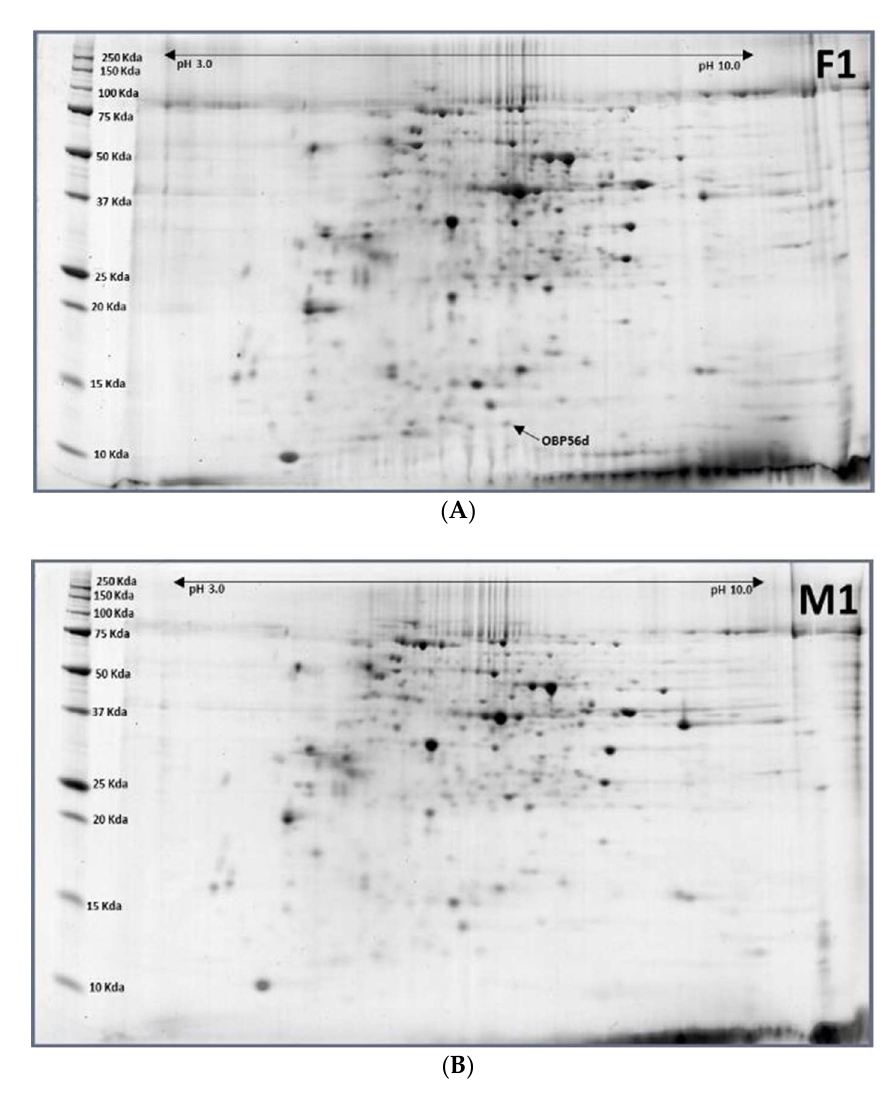
Figure 5. Representative images of 1-day-old females (F1) ( A ) and 1-day-old males (M1). ( B ) of Bactrocera latifrons. Images were labelled with protein names (spot ID#) (F1/M1 ratios). 2.6. Females (9-Day-Old)–Males (9-Day-Old) There were 15 differentially expressed protein spots between nine-day-old females and males. Four down-regulated protein spots contained four proteins, and 11 up-regulated protein spots contained eight proteins (Table 5 and Figure 6). Females significantly and differentially expressed vitellogenin-1 by >120 fold over